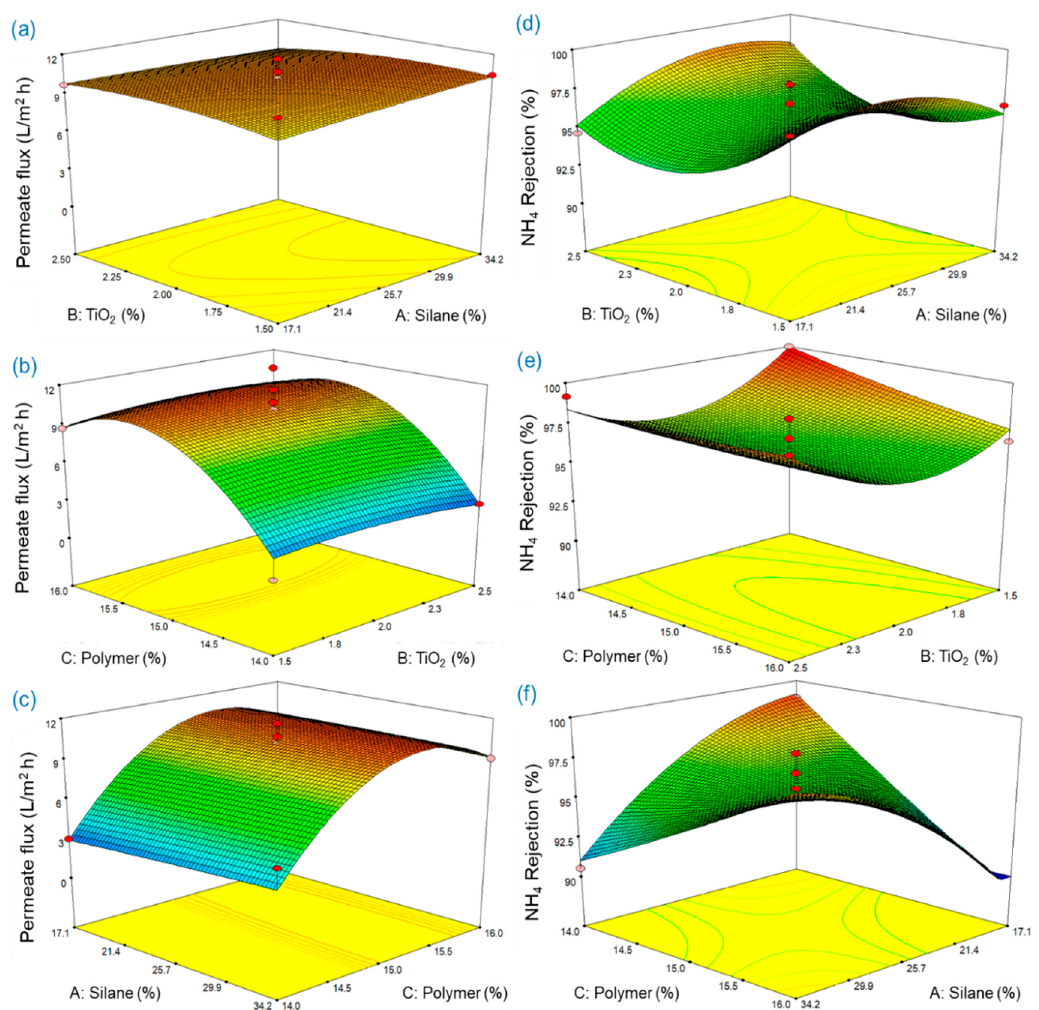
Figure 11. Estimated response surface for permeate flux (L/m 2 ∙ h) showing the influence of ( a ) silane and TiO 2 concentrations, ( b ) TiO 2 and polymer concentrations and ( c ) polymer and silane concentrations. Estimated response surface for ammonium rejection (%) showing the influence of ( d ) silane and TiO 2 concentrations, ( e ) TiO 2 and polymer concentrations and ( f ) polymer and silane.